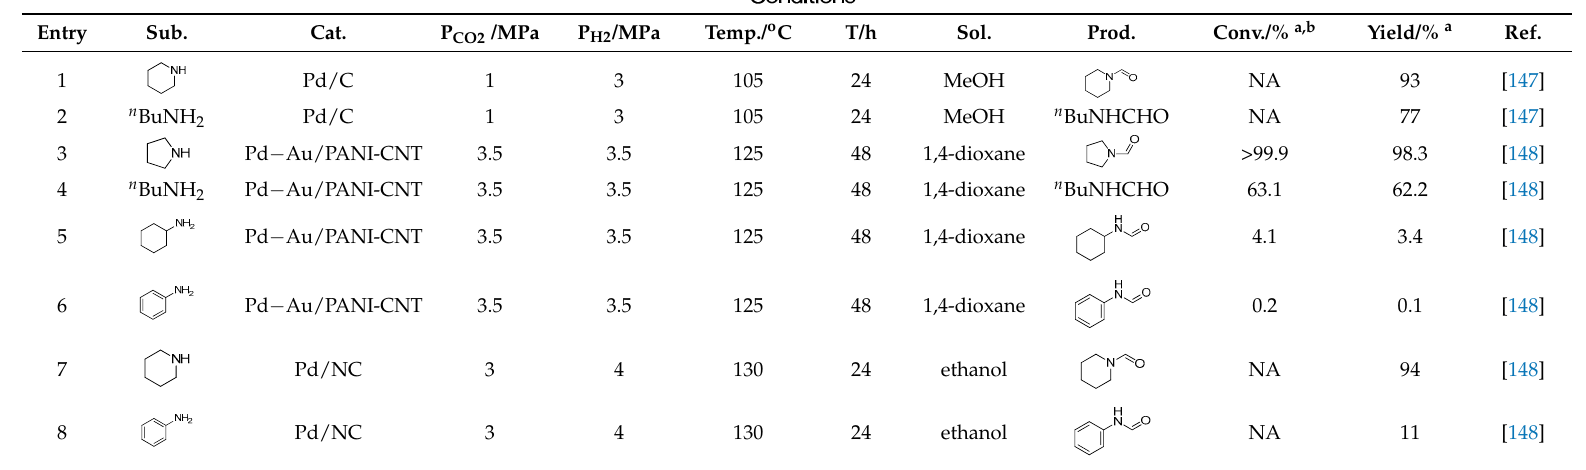
Table 5. N-Formylation of typical amines with CO 2 /H 2 .